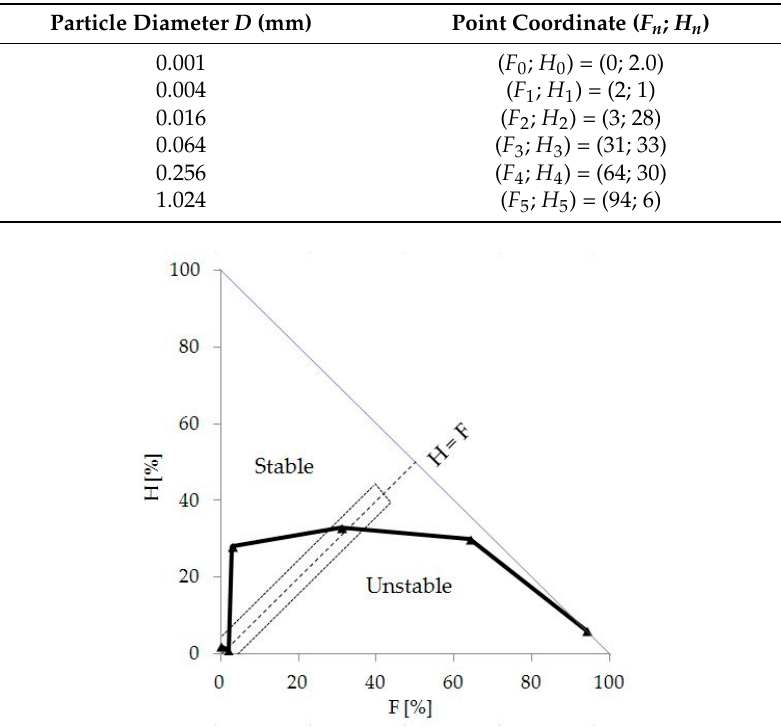
Table 4. F n and H n point coordinates